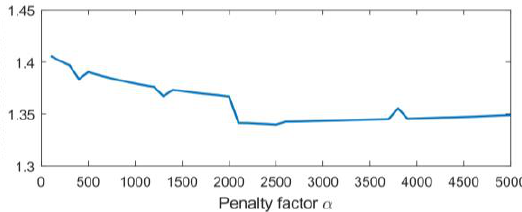
Figure 9. Relationship between quadratic penalty factor α and MFE value of the reconstructed MF signal.